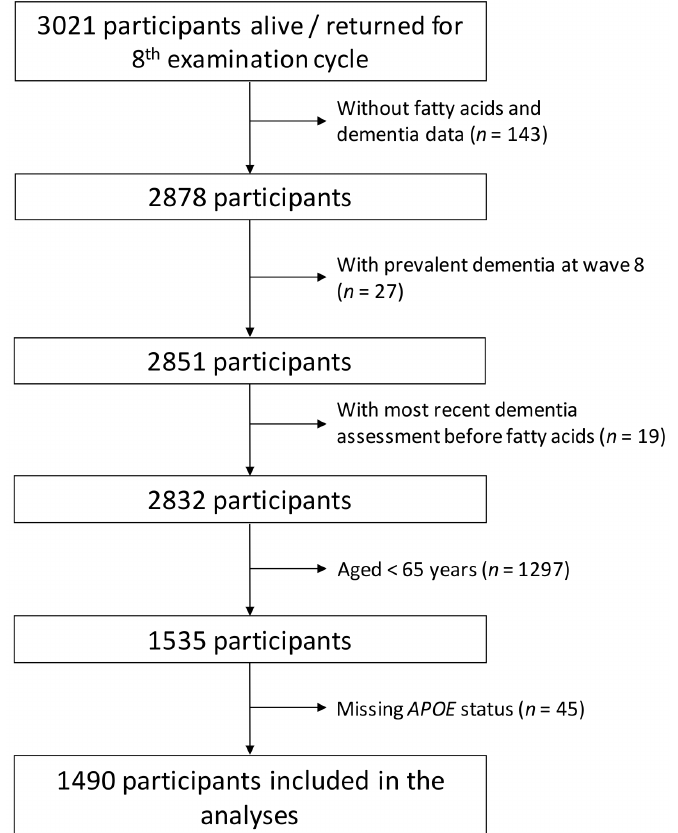
Figure 1. Flowchart of the study.